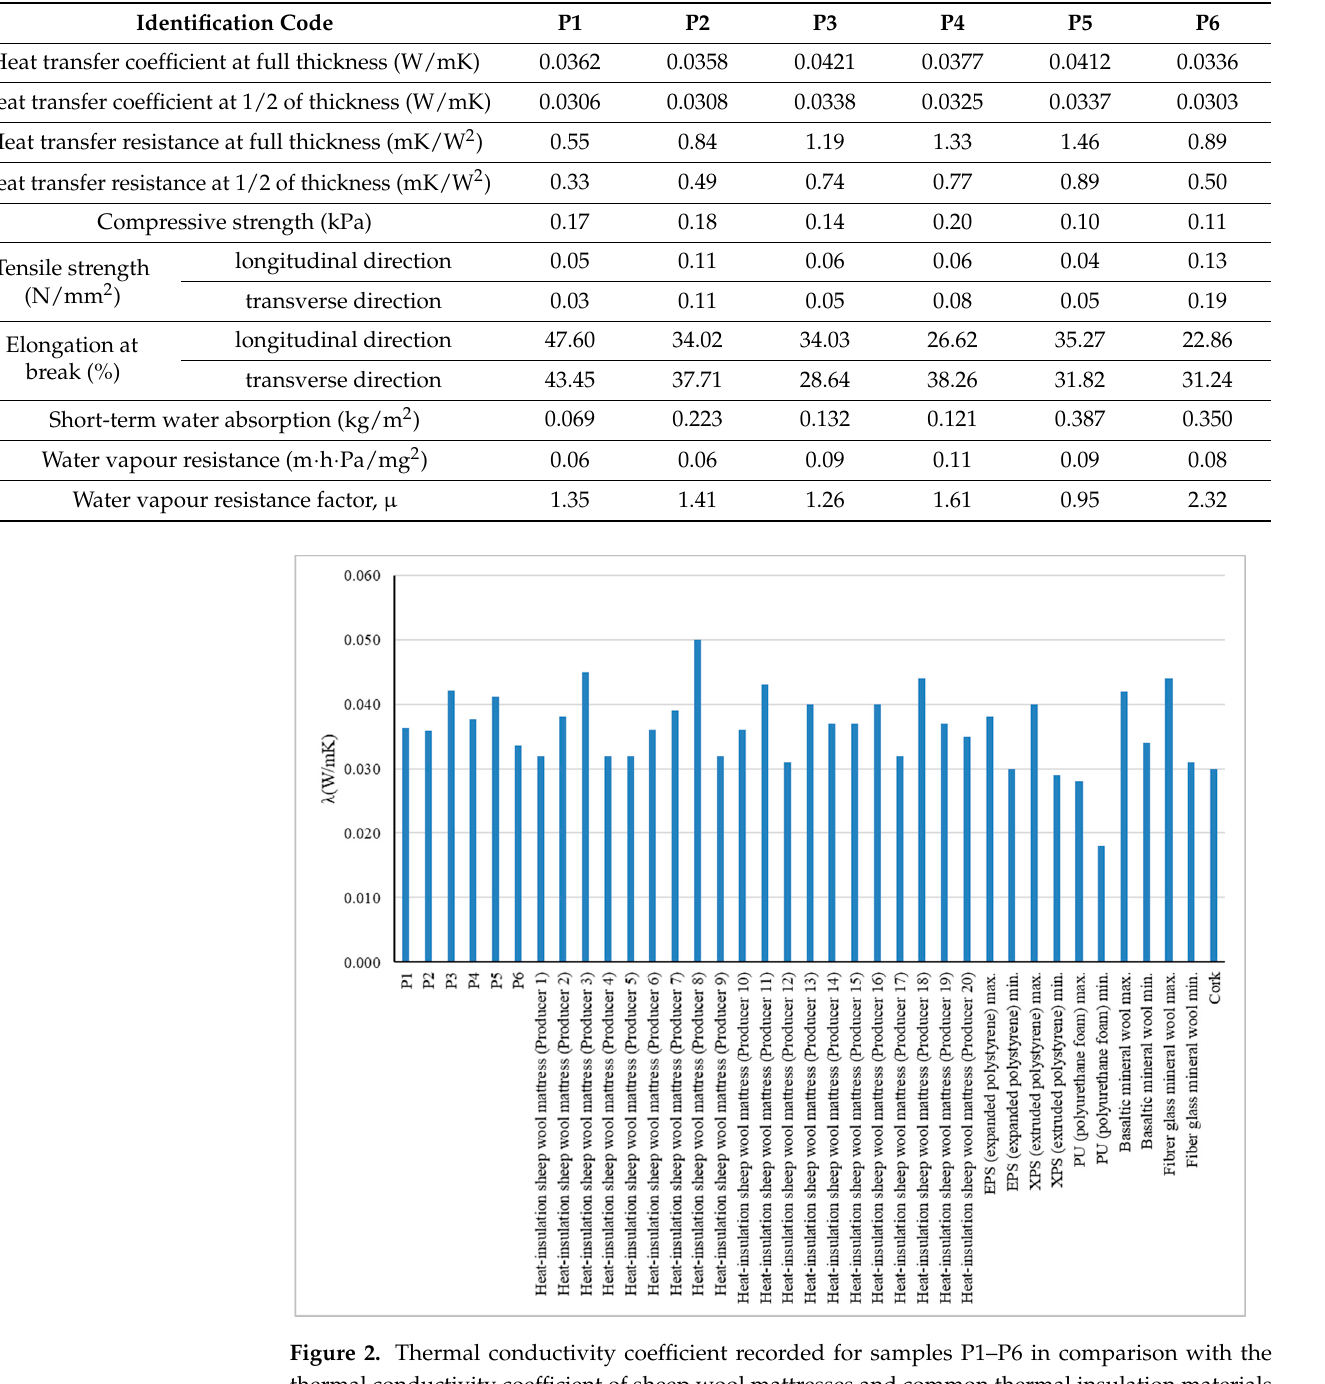
Table 4. Physical-mechanical performance of thermal-insulation mattresses produced using recycled textile and PET waste and natural fibres of plant and animal origin.